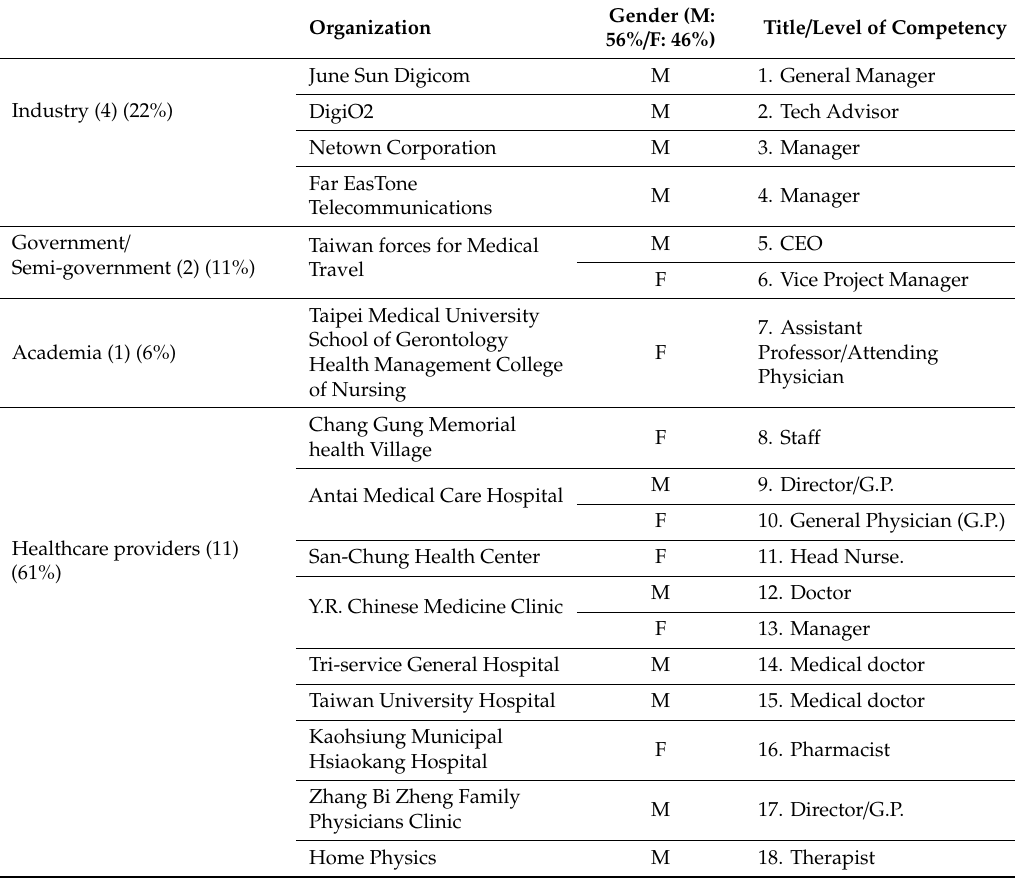
Table 4. Pilot interviewees’